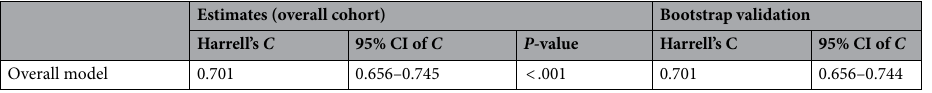
Table 3. Model performance. Cox proportional hazard model on overall survival. Complete-case analysis, n = 552 of 558, missing data as presented in Table 1; number of events was 197; global test for statistical significance of the model, LR-test: P < .001. COPD, chronic obstructive pulmonary disease; not having the condition served as reference group; kidney function as estimated glomerular filtration rate according to the “Modification of Diet in Renal Disease Study” equation; inversed Hazard Ratios (HR) are presented to facilitate reading and comparability to previously published data; the HR increases as the eGFR decreases and vice- versa.